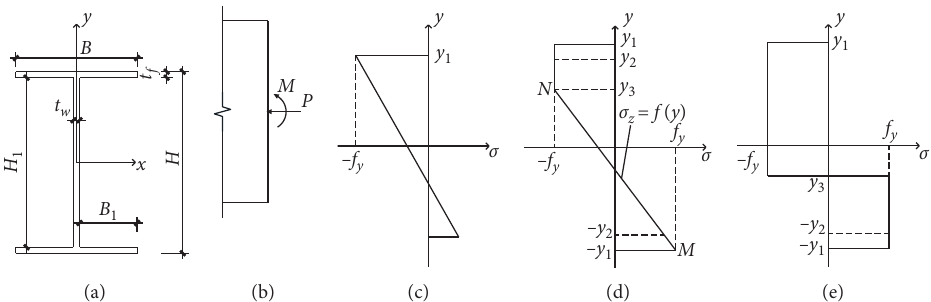
Figure 12: The characteristics of undamaged H-shaped cross section when the value of axial force is constant: (a) H-shaped cross section; (b) internal force of the cross section; (c) full-sectional elastic stress distribution; (d) single-sided elastic stress distribution; (e) double-sided elastic stress distribution.